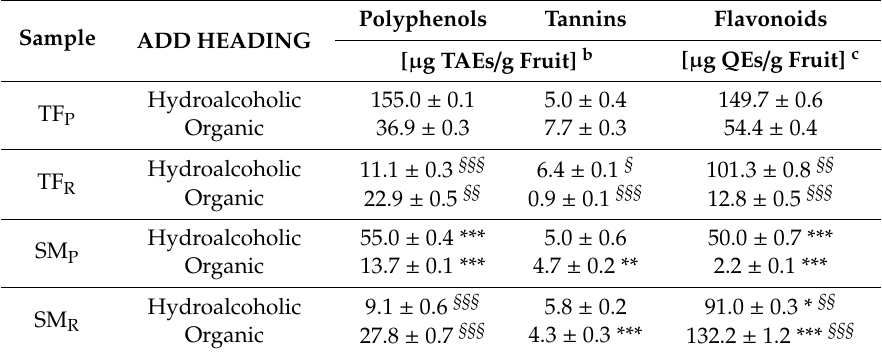
Table 6. Amounts of total polyphenols, tannins and flavonoids in Bligh–Dyer hydroalcoholic and organic extracts of both pink and red fruits from Solanum lycopersicum var. TF and SM a